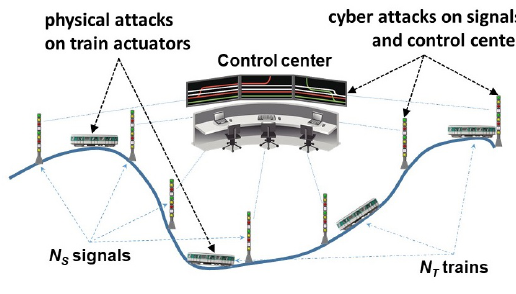
Figure 2. Metro system.